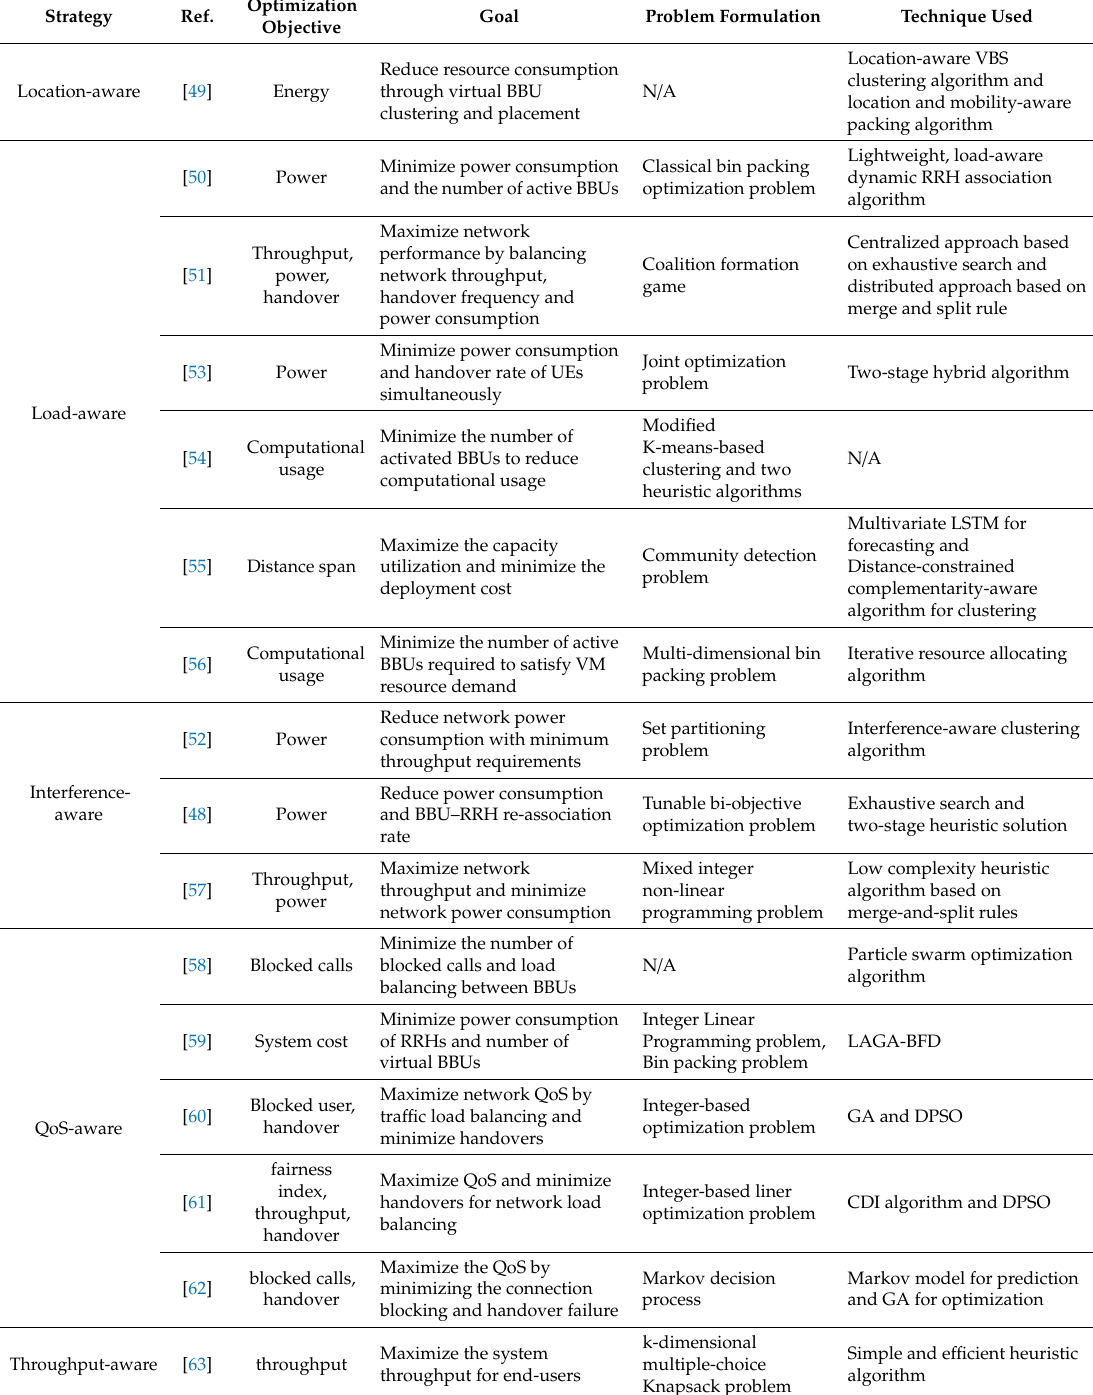
Table 5. Comparison of RRH clustering